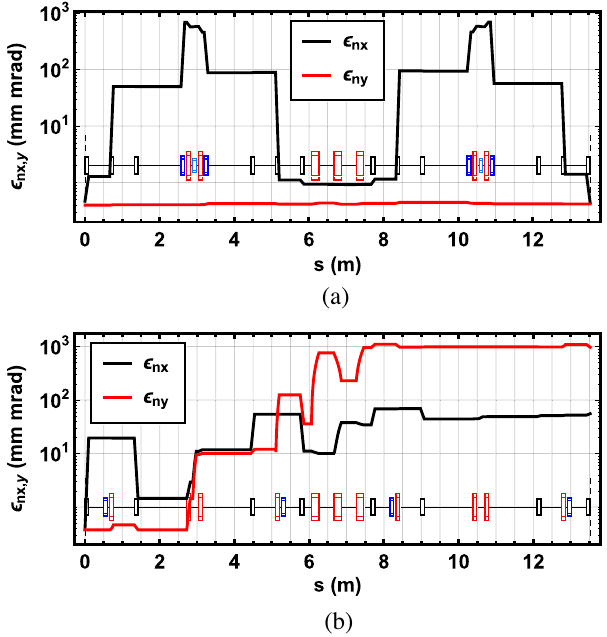
FIG. 16. Beam emittance evolution in additional dipole and additional quadrupole configurations. (a) Beam emittance evo- lution in additional dipole solution. (b) Beam emittance evolution in additional quadrupole